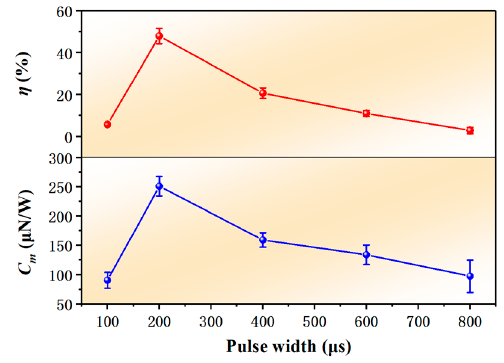
Figure 11. C m and η as functions of laser pulse width.